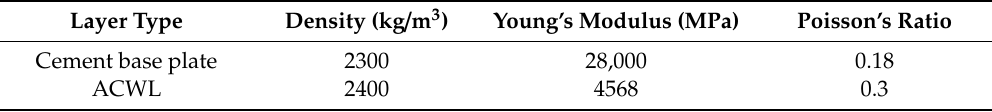
Table 2. Material parameters of the cement base plate and ACWL.